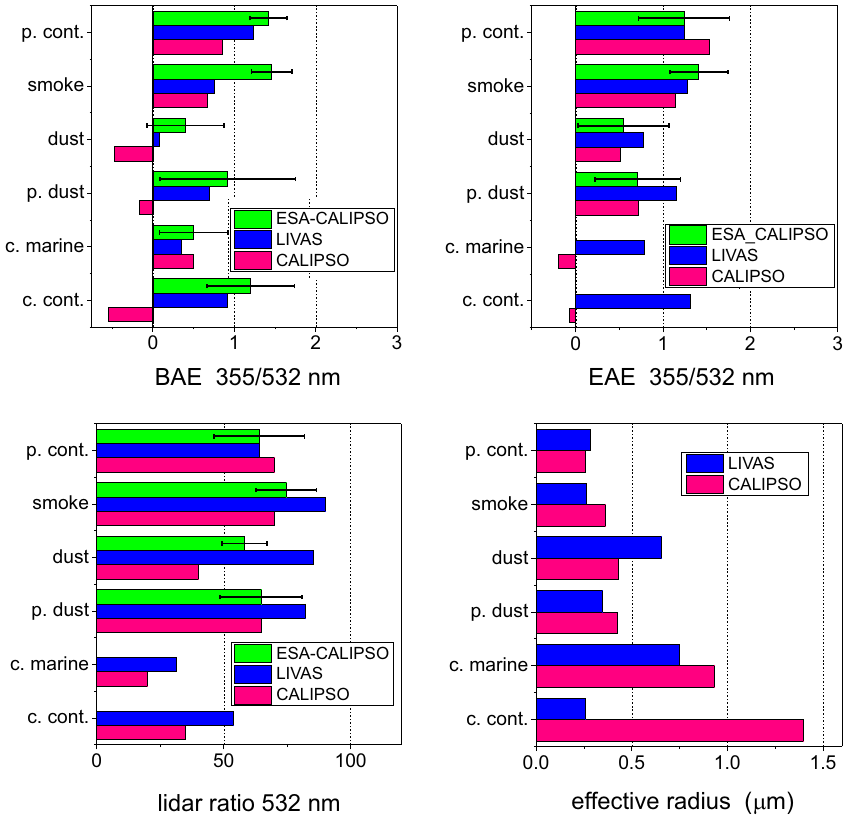
Figure 7. Comparison of LIVAS and CALIPSO with ESA-CALIPSO values for BAE at 355/532nm (upper left), EAE at 355/532nm (upper right), lidar ratio at 532 nm (lower left) and effective radius (lower right). Table 3. LIVAS and CALIPSO LR, SSA and effective radius.